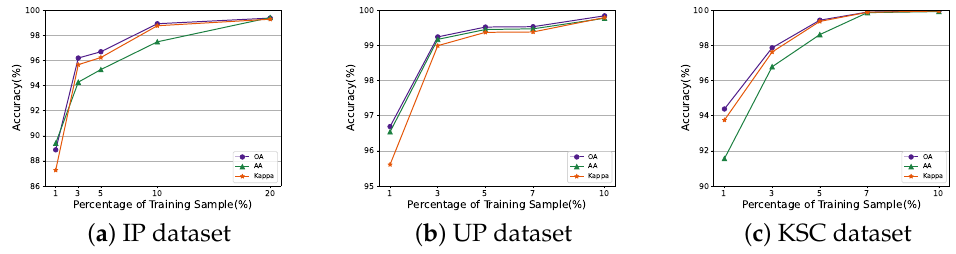
Figure 5. The effect of the number of training